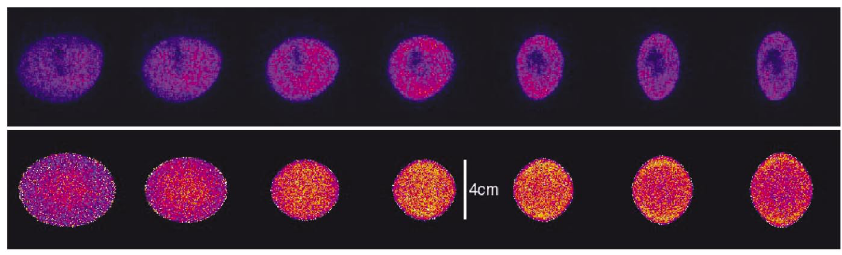
FIG. 10. (Color) Experimental (top) and theoretical (bottom) NTX beam profiles for a nonneutralized beam 1 m downstream from the exit of the final-focus system.